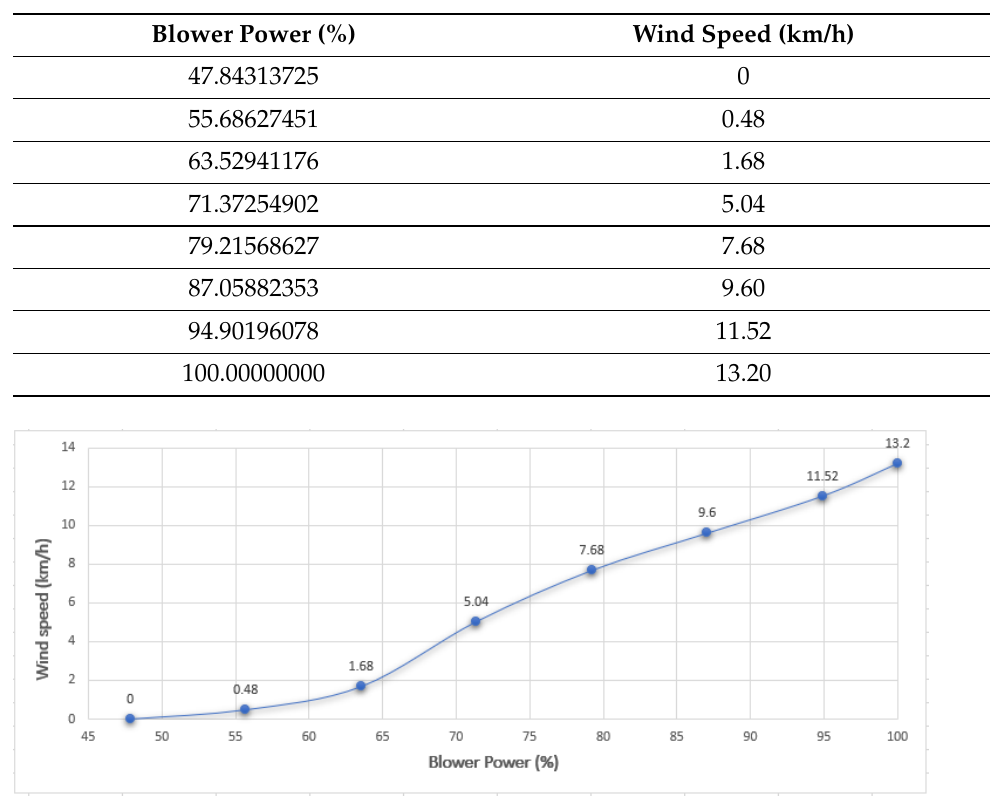
Table 1. Data collection of the wind speed measured by the participant.